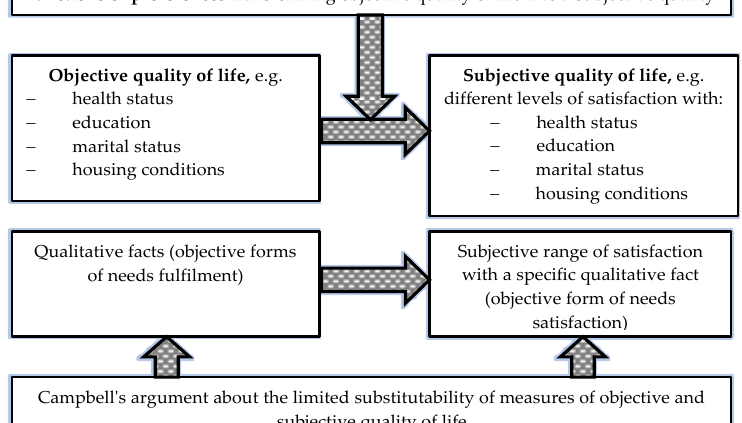
Figure 1. Flowchart of the transformation of objective quality of life into its subjective perceptions. Source: author’s own.